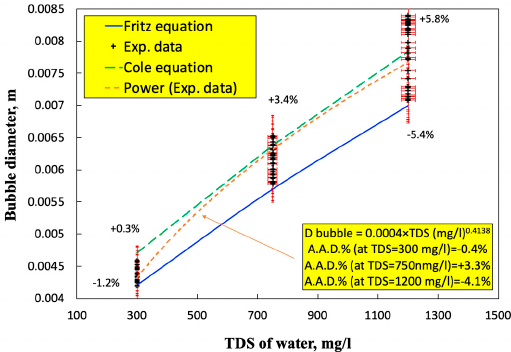
Figure 8. Dependence of the bubble diameter on the TDS value, and a comparison between the results calculated with Fritz and Cole equations against experimental